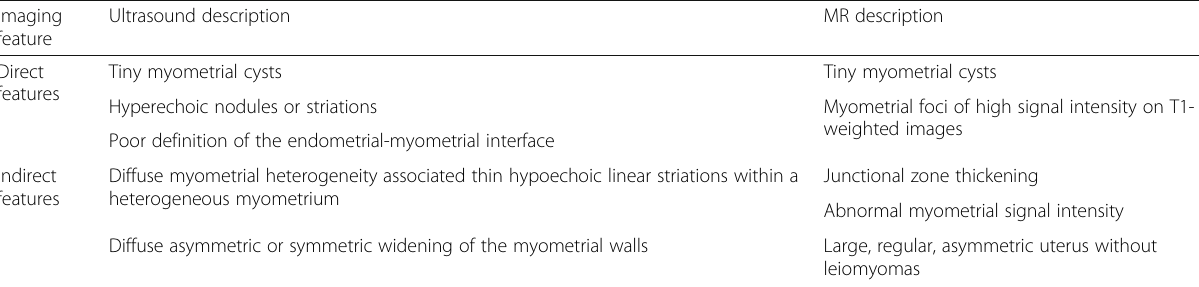
Table 1 Direct and indirect imaging features of adenomyosis Imaging Ultrasound feature